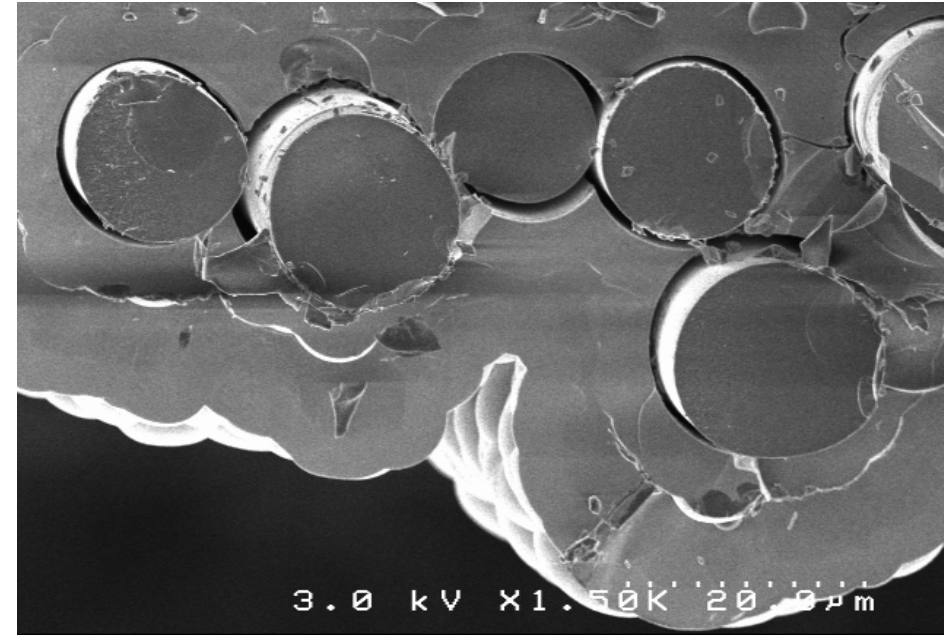
Figure 12. Example of group of filaments, with a smooth fracture surface close to the filament on the left, and with typical marks of slow crack growth. Note that the PyC interphase had disappeared.